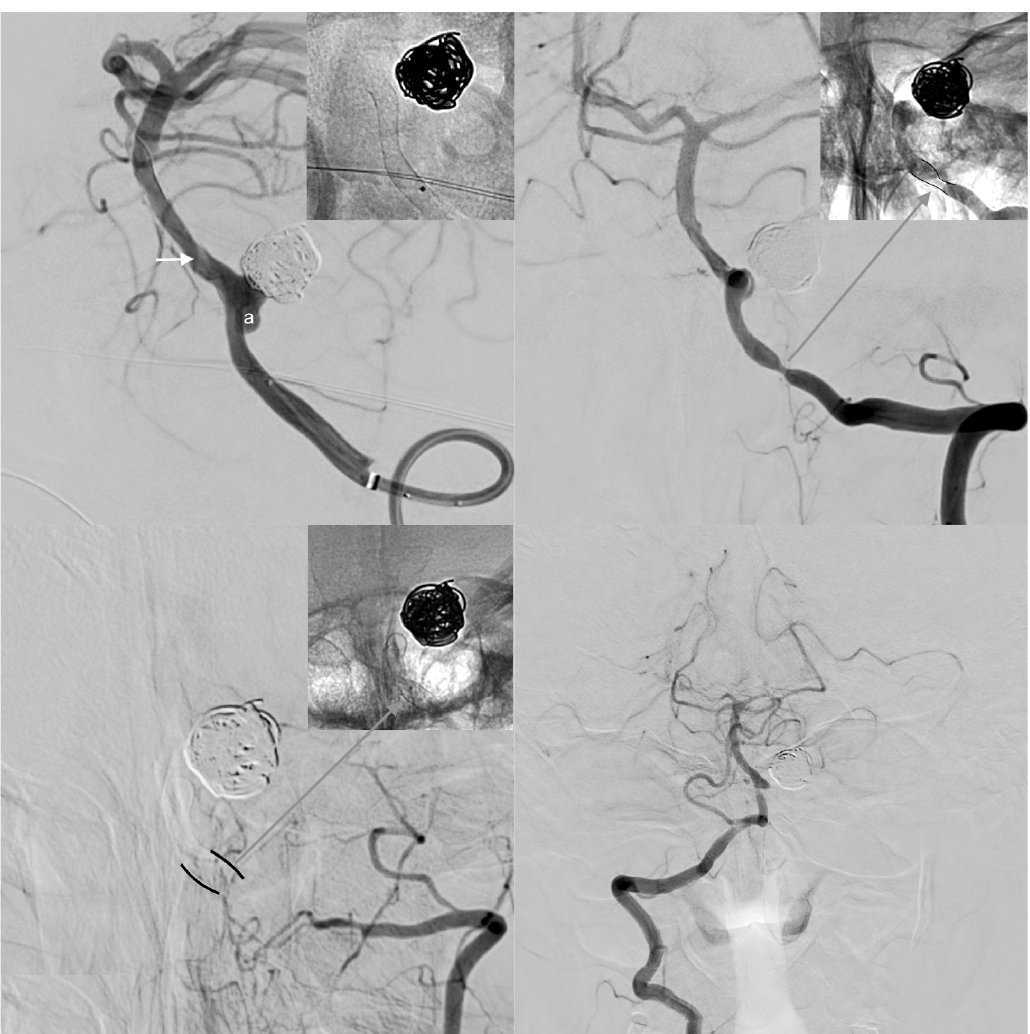
Figure 2. Clinically inapparent case of vasospasm-associated occlusion of a left-sided, dominant vertebral artery after FDS implantation for treatment of a de novo aneurysm arising from the posterior inferior cerebellar artery (PICA) orifice. Upper row: The left image shows the left V4 segment carrying a broad-based, de novo aneurysm (a) evolving in close proximity to a previously coiled PICA aneurysm. Note the radiogram showing the optimally implanted, well-unfolded FDS, which intentionally spared the VBA confluens aiming to preserve the hypoplastic right vertebral artery as a potentially important collateral vessel (white arrow: wash-out caused by inflow from the right-sided V4). The right image shows the early follow-up DSA five weeks after implantation. Note the short, high-grade stenosis along the proximal landing zone. The radiogram detail in the upper right corner illustrates compression of the stent (black lines), additional neointimal hyperplasia (white area bordering the stent), and the residual lumen (gray area). The patient complained of recurrent episodes of cervical–occipital headaches on the left side, but otherwise remained asymptomatic.Inferior row: control angiogram and non-enhanced device image five months after treatment. The left V4 segment is occluded, and the V3 segment is reduced in size. Note the re-unfolded FDS in the radiogram (upper right corner). The formerly hemodynamically non-essential right-sided vertebral artery now independently supplies the posterior fossa. The patient did not experience a neurological deficit at any time.